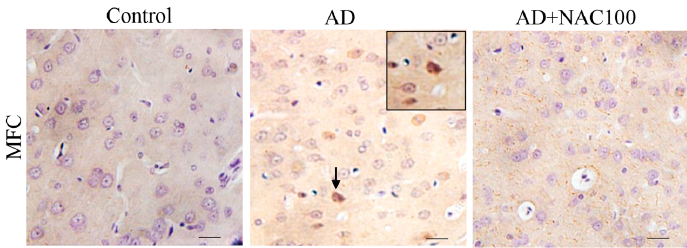
Figure 8. Photomicrographs of the prefrontal cortex in different groups of rats immunostained for neurofibrillary tangles (anti-tau protein). Note the tau positive neurons (Arrow) in AD group. (Photomicrographs of Sham and AD + NAC 50 groups are avoided for simplicity). Scale bar = 40 µ. MFC—Media prefrontal cortex.